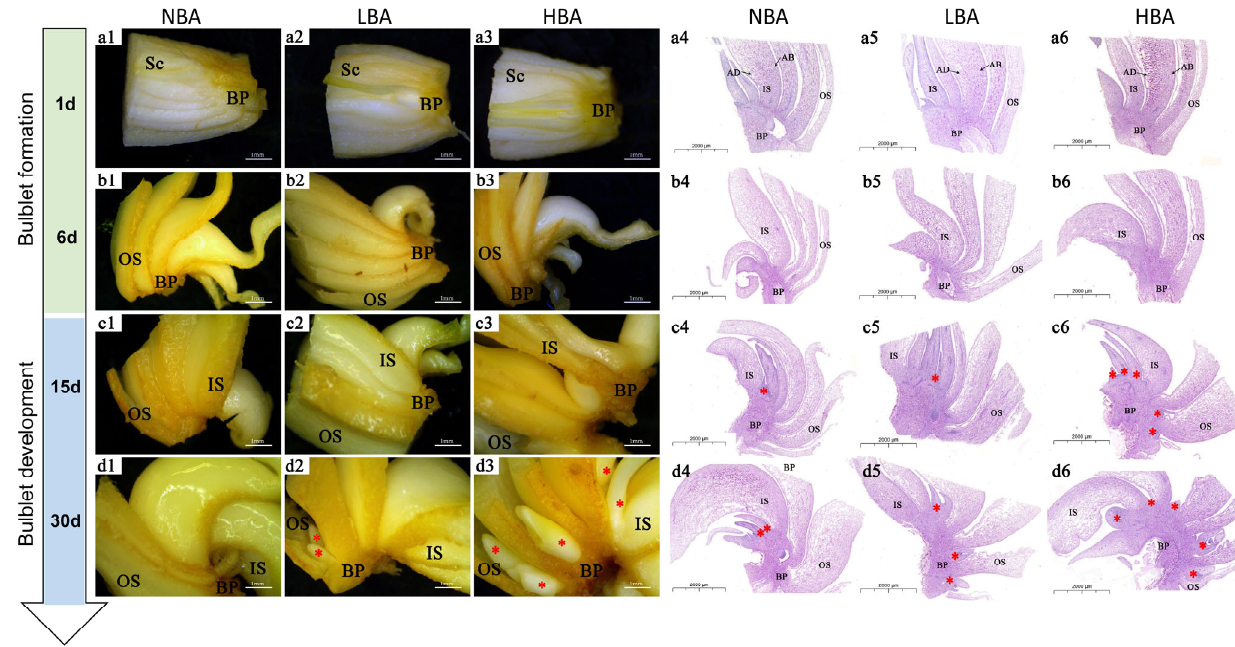
Figure 2. Morphological and histological observations of the in vitro bulblets formation and development process. ( a1 – d1 , a2 – d2 , a3 – d3 ) represent in vitro bulblets formation and development of NBA, LBA and HBA group under anatomic microscope observation, respectively; ( a4 – d4 , a5 – d5 , a6 – d6 ) represent in vitro bulblets formation and development of NBA, LBA and HBA group under anatomic microscope observation, respectively. Sc: scale, BP: basal plate, IS: inner scales, OS: outter scales. Red asterisks indicate the newly formed regenerated bulblets.